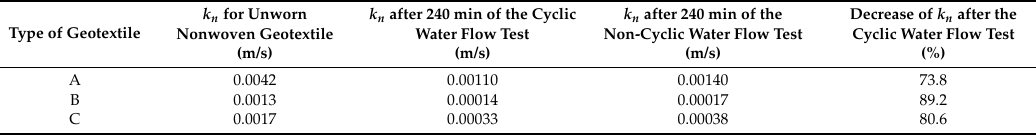
Table 6. Coefficients of water permeability k n of the tested nonwoven geotextile samples.